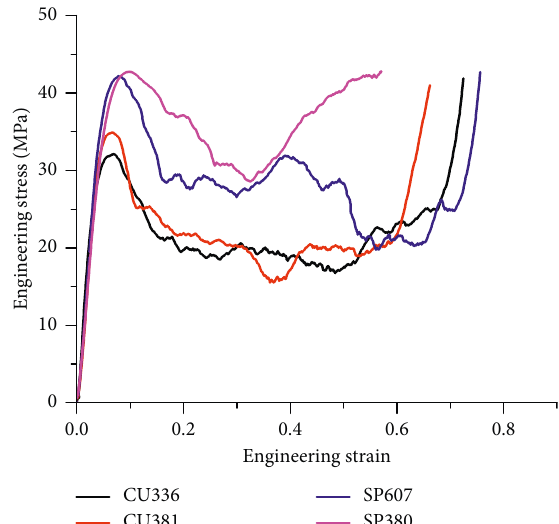
Figure 11: Mechanical strength of foams under compression testing at a strain rate of 0.001s − 1 made by cubic KCl with a mean particle size of 336 µ m (CU336), cubic KCl with a mean particle size of 381 µ m (CU381), spherical KCl with a mean particle size of 607 µ m (SP607), and spherical KCl with a mean particle size of 380 µ m